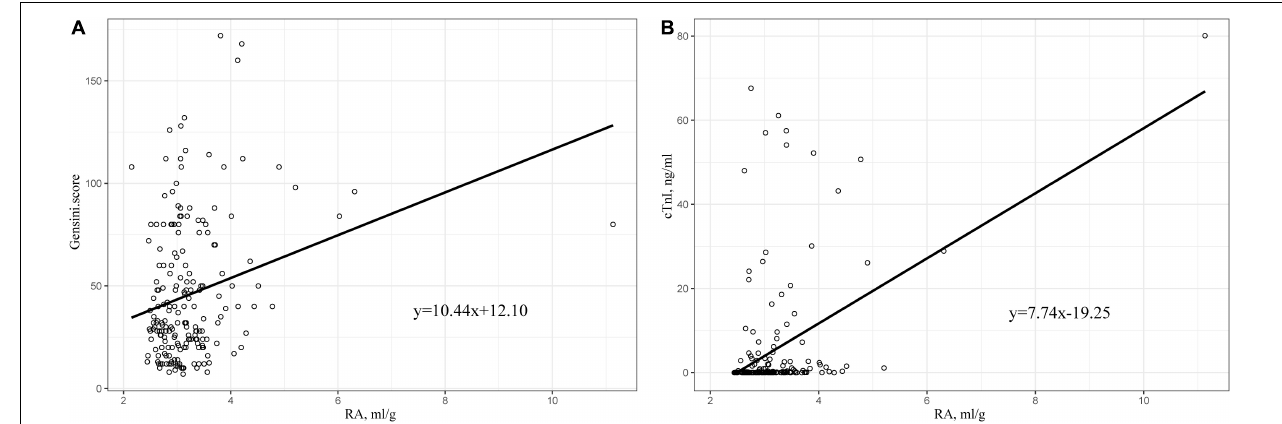
FIGURE 5 | (A) Scatter plot of the relationship between RA and Gensini score. (B) Scatter plot of the relationship between RA and cTnI. RA, the ratio of red cell volume distribution width to albumin; cTnI, cardiac troponin I.